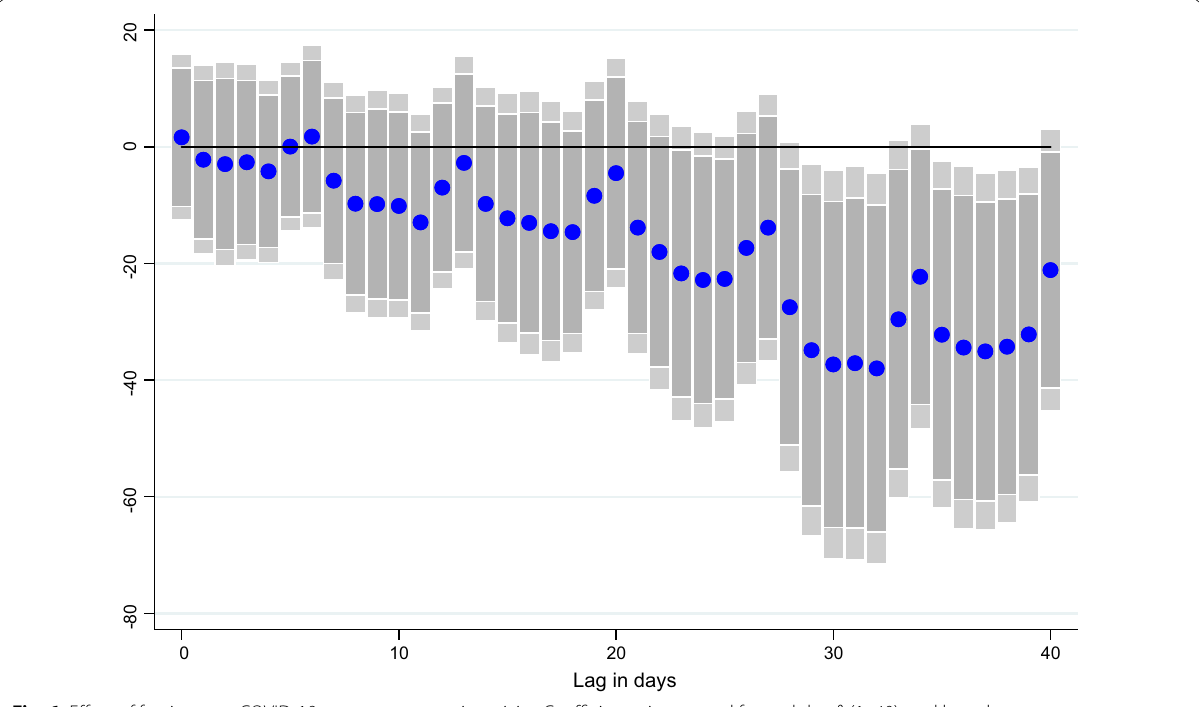
Fig. 6 Effect of foreign new COVID-19 cases on economic activity. Coefficient γ is reported for each lag ℓ (1–40), and based on � Y i , t = α + µ i + γ t + β SV i , t − l + γ TradingPartner j , t − m + θ X i , t − l + ε i , t for a sample of 43 countries using daily data from December 20, 2020–June 16, 2021. where